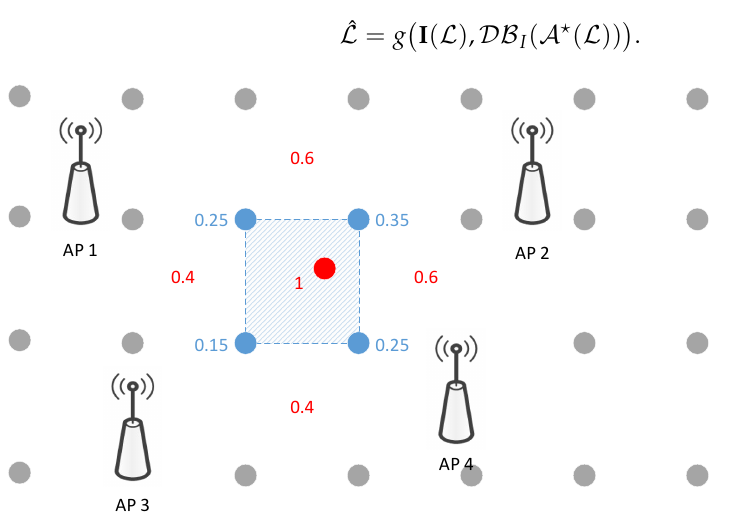
Figure 3. The illustration of coarse localization. The nearest N p RPs are selected by the KNN algorithm and form a circle area, which is the coarse localization area. The gray dots and red dots are RP positions and test positions,